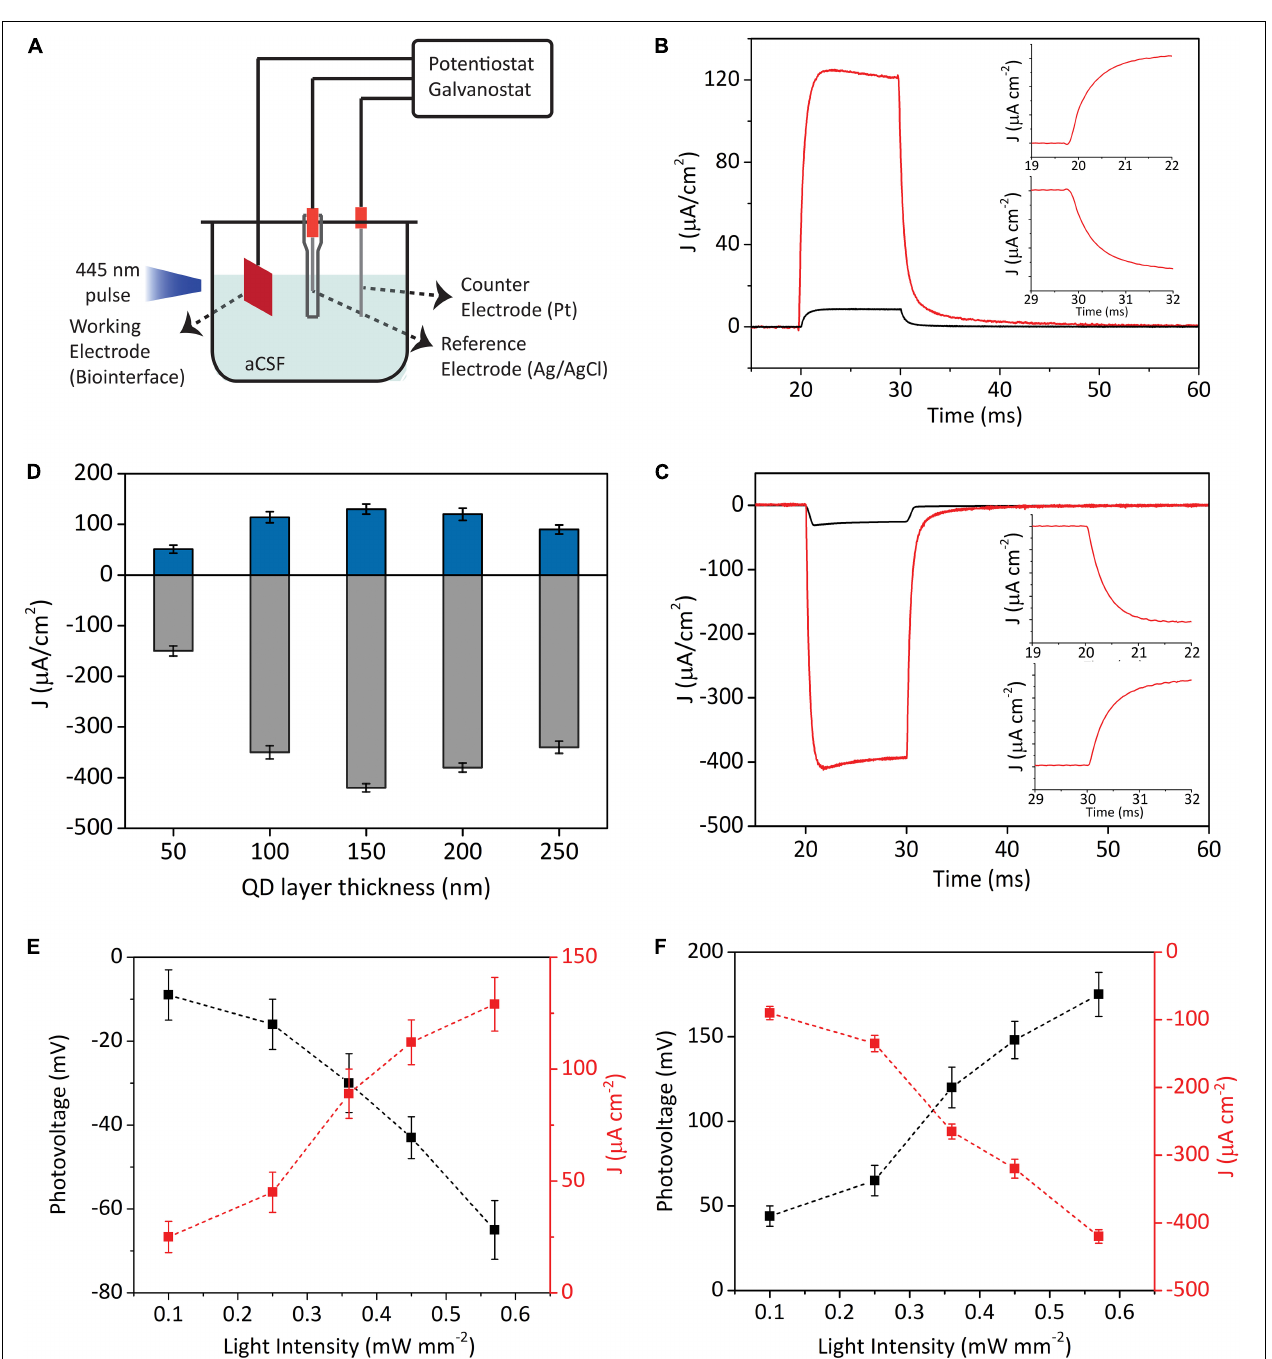
FIGURE 2 | Characterization of the photoelectrical performance of biointerfaces. (A) Three-electrode electrochemical photocurrent measurement setup. (B,C) Photocurrent density of type I (B) and type II (C) devices in biological medium (illumination: blue LED at the wavelength of 445 nm, 10 ms pulse width, 0.57 mW mm − 2 optical power density). Black lines represent when InP core QDs are used as the photoactive layer, while red lines show when InP/ZnS core/shell QDs are used as the photoactive layer. Inset (B,C) top: Zoomed onsets of photocurrents. Inset (B,C) bottom: Zoomed offsets of photocurrent. (D) Photocurrent densities of type I (blue bars) and type II (gray bars) biointerfaces as a function of photoactive layer thickness (Mean ± SD for N = 8). (E,F) Photovoltage and photocurrent density responses of type I (E) and type II (F) devices under different light intensities (illumination: blue LED at 445 nm, 10 ms pulse width) (Mean ± SD for N = 8).